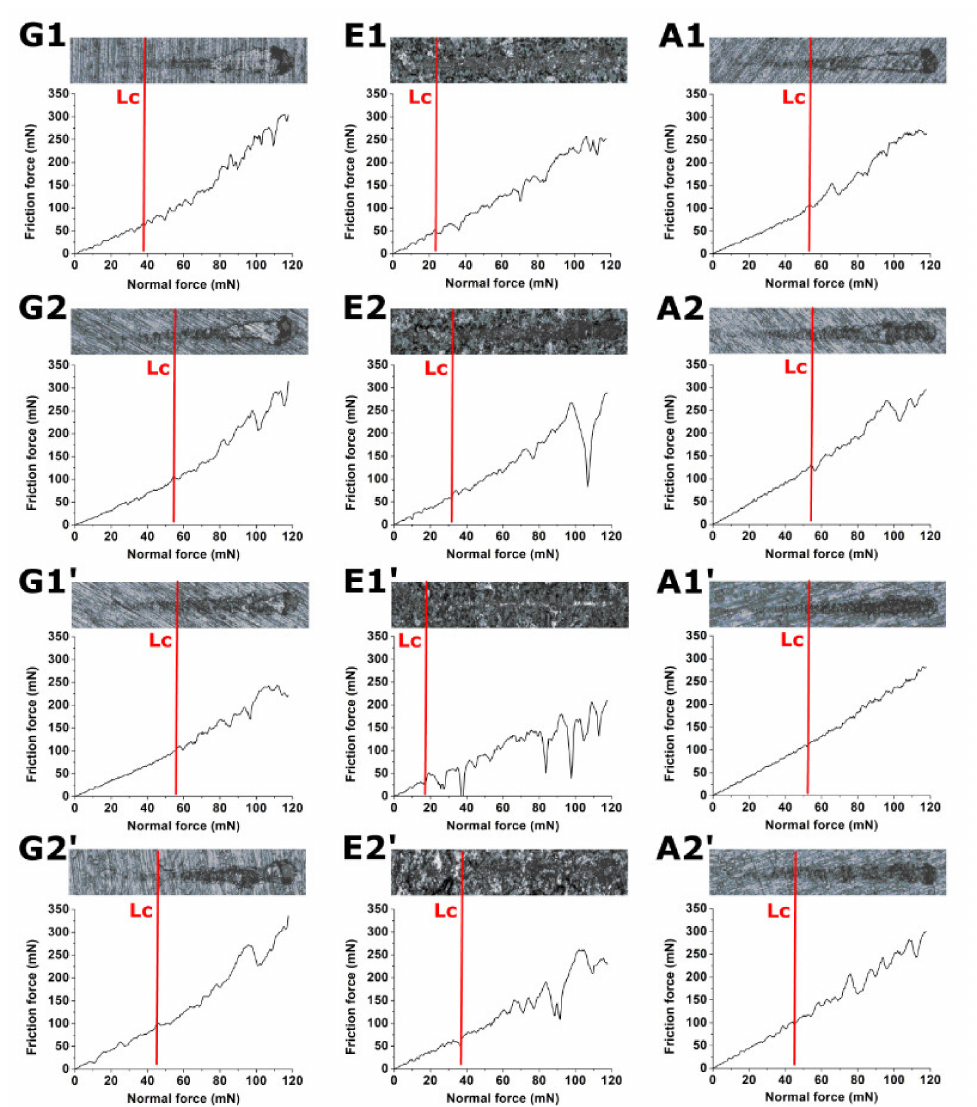
Figure 7. Scratch test curves obtained for coated specimens along with a single-scratch image and marked critical load value